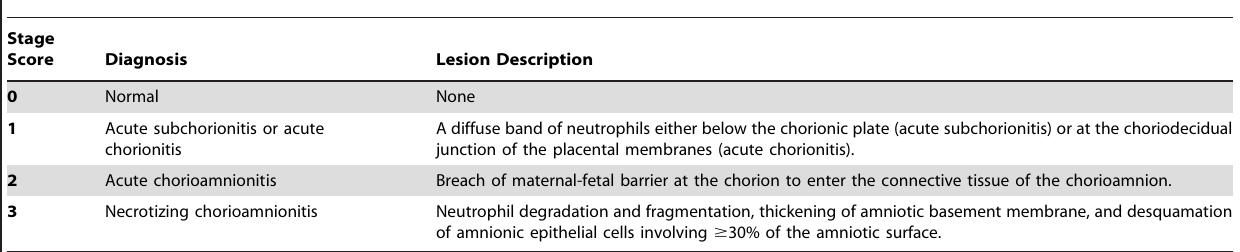
Table 1. Lesion scoring criteria for maternal inflammatory response